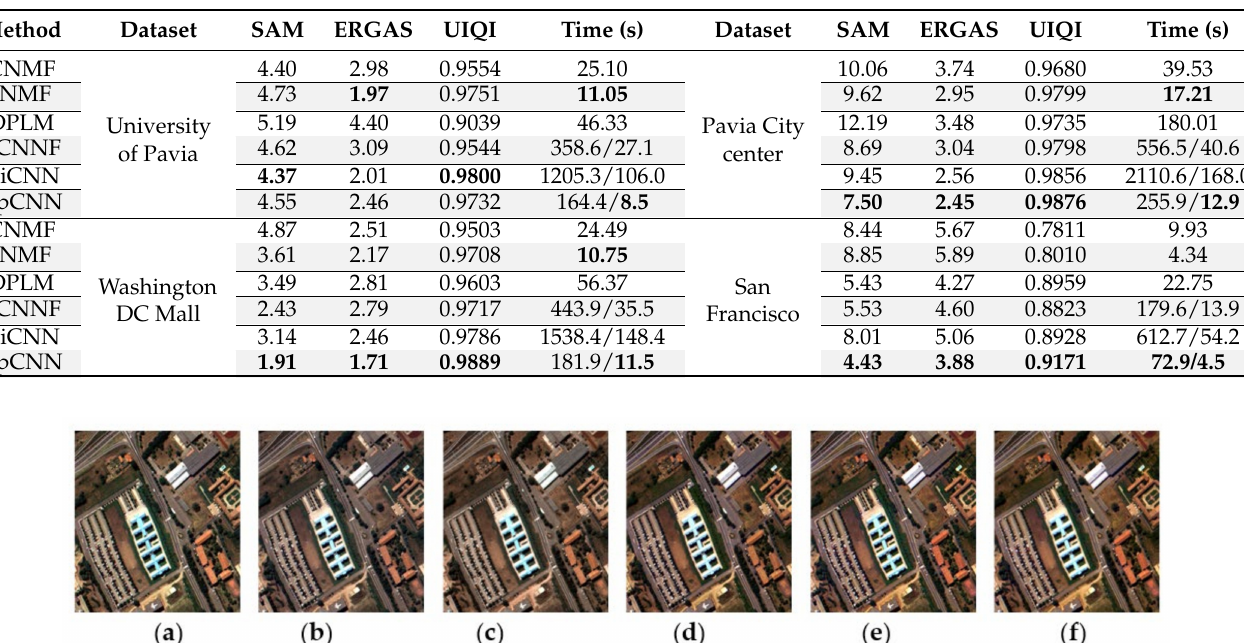
Table 3. Numerical evaluation of hyper-sharpening results under resolution ratio of 6 ( s = 6).